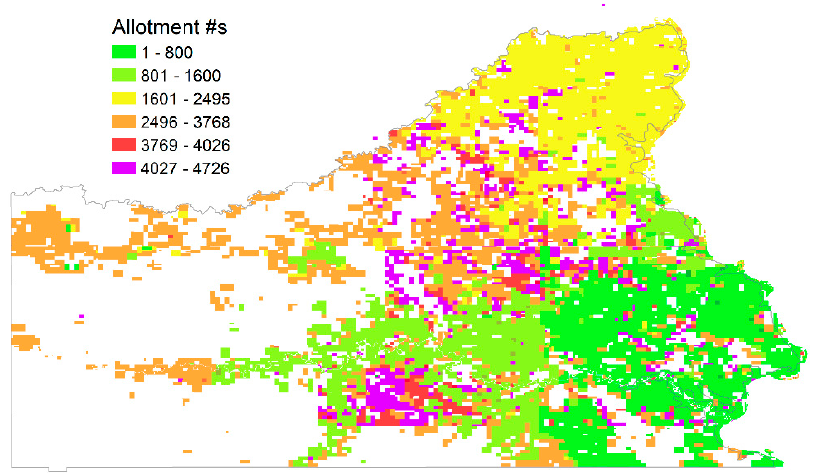
Figure 15. Categorized allotment data based on allotment number. The pattern illustrates the temporal progress of allotment across the reservation as it spreads from the southeast corner.